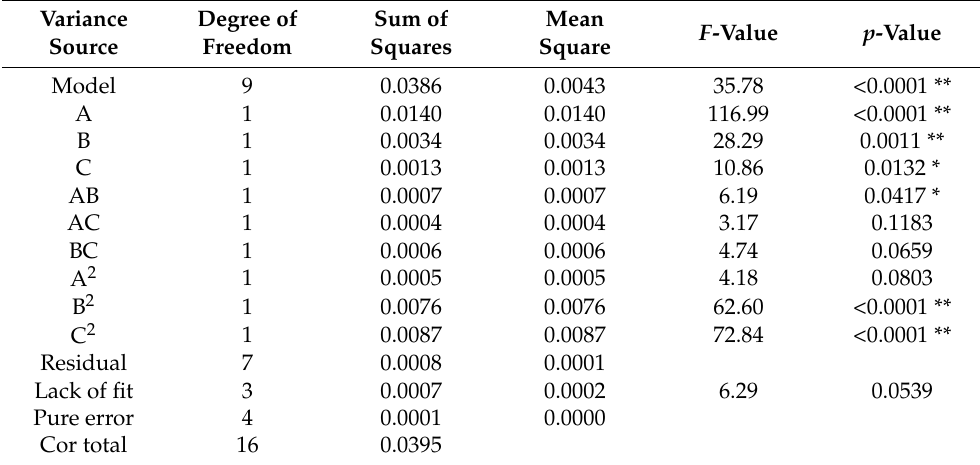
Table 3. ANOVA for the response surface quadratic model (Cor Total: Corrected Total Sum of